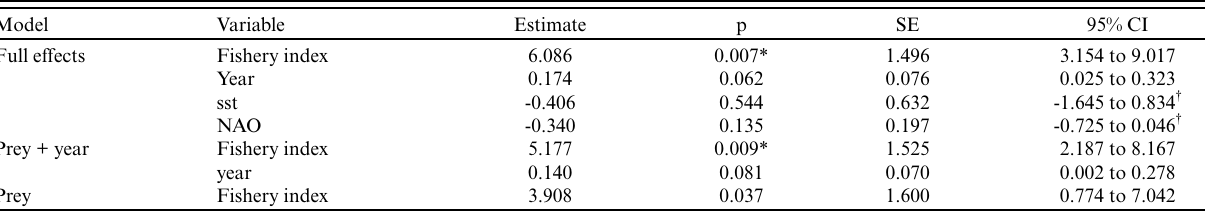
* = significant. † = confidence intervals overlap with zero. NAO = North Atlantic Oscillation.